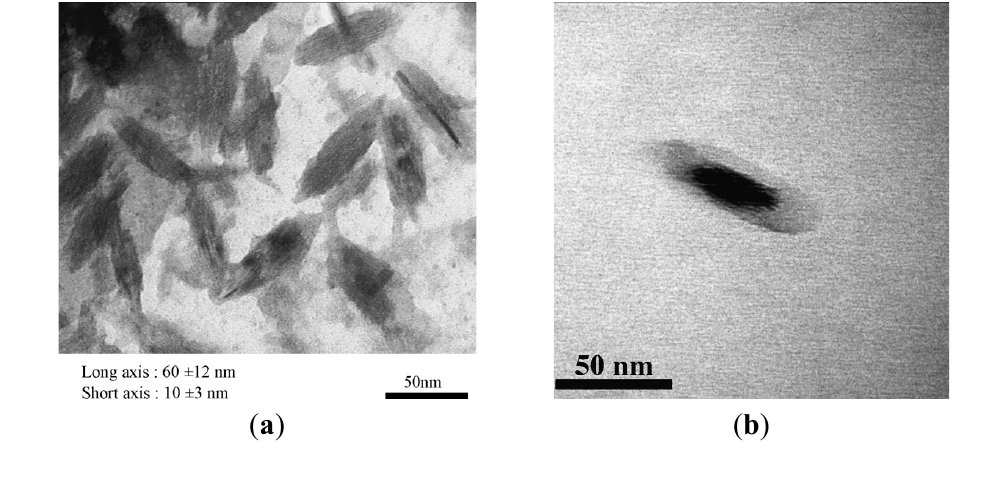
Figure 7. Energy filtering transmission electron microscopy (EFTEM) zero-loss images of: ( a ) β-FeOOH NPs; and ( b ) poly(ethylene glycol)- block -poly(aspartic acid) (PEG- b -PAsp)- coated β-FeOOH NPs. Reprinted with permission from [29]. Copyright 2007 Elsevier